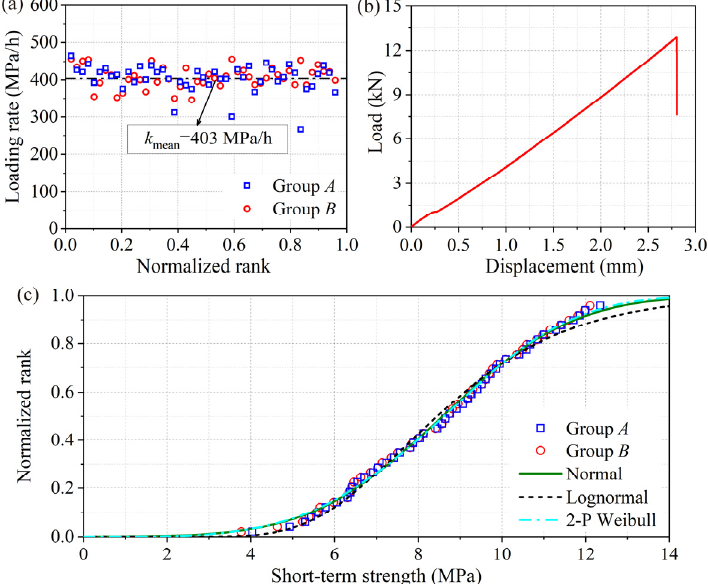
Figure 3. Results of short-term test: ( a ) the loading rate k , ( b ) a typical load–displacement curve, ( c ) the cumulative probability distribution of short-term strengths.